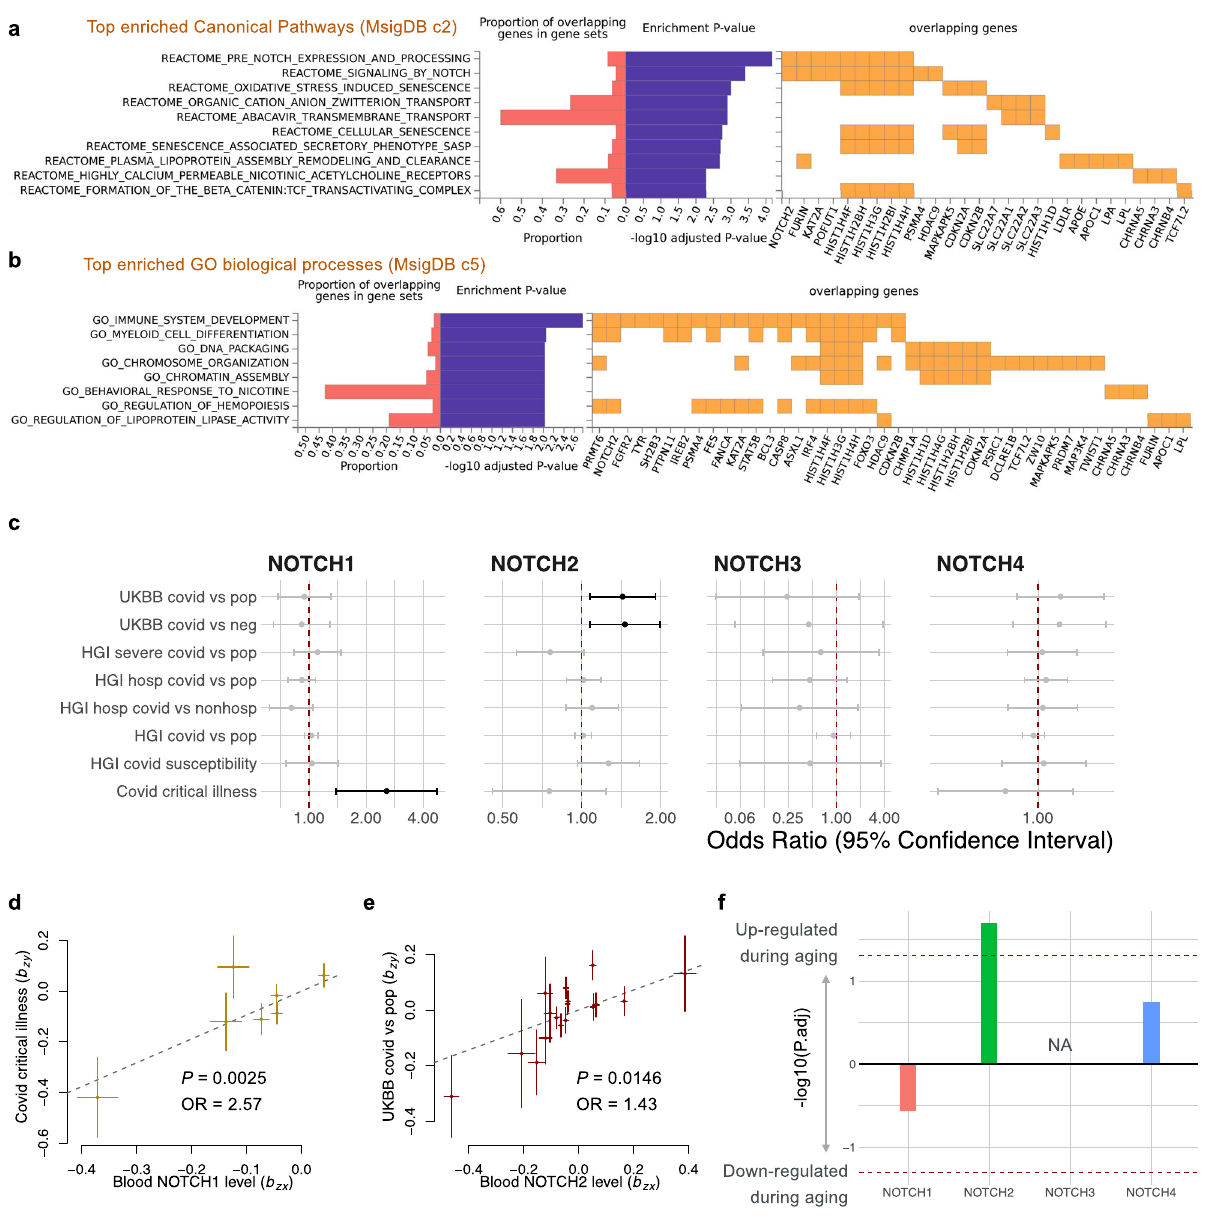
Fig. 3 Bivariate genomic scan identi fi ed Notch signaling as an age-related COVID-19 risk. Gene set enrichment analysis of aging-related COVID-19. Top signi fi cantly enriched ( P adjusted < 0.05) canonical pathways ( a ) and GO biological processes ( b ) are shown. c Forest plot showing Mendelian randomization estimates for the causal effect of blood NOTCH2 expression on the risk of COVID-19 infection. Error bars show the 95% con fi dential interval. Nominally signi fi cant effects ( P < 0.05) are in black. Error bars show the 95% con fi dential interval. d, e Plots of effect size of all genetic instruments from blood eQTLs for NOTCH1 versus those for COVID-19 critical illness ( d ) and NOTCH2 versus UKBB COVID-19 infection ( e ). Error bars represent standard errors. f Bar plot showing the age-related differential expression of NOTCH1-4 in blood. The y -axis represents the − log10(P.adj) × sign of changing direction, i.e., the positive value represents an age-related increase. UKBB UK Biobank, HGI Host Genetics